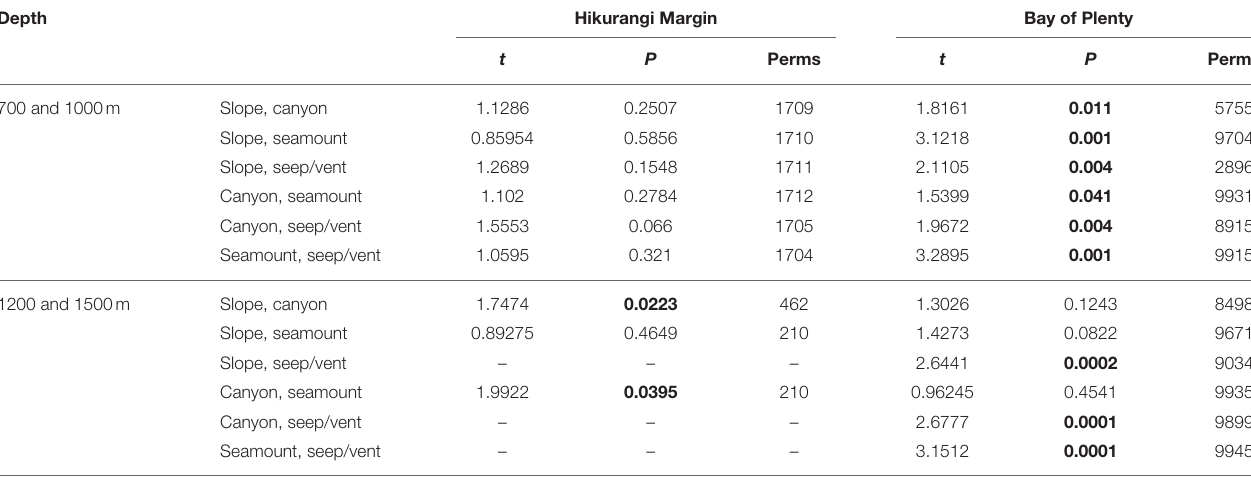
TABLE 5 | Results of pairwise PERMANOVA analyses testing for the effects Habitat (slope, canyon, seamount, and seep or vent habitats) on trophic structure in Hikurangi Margin and Bay of Plenty regions.